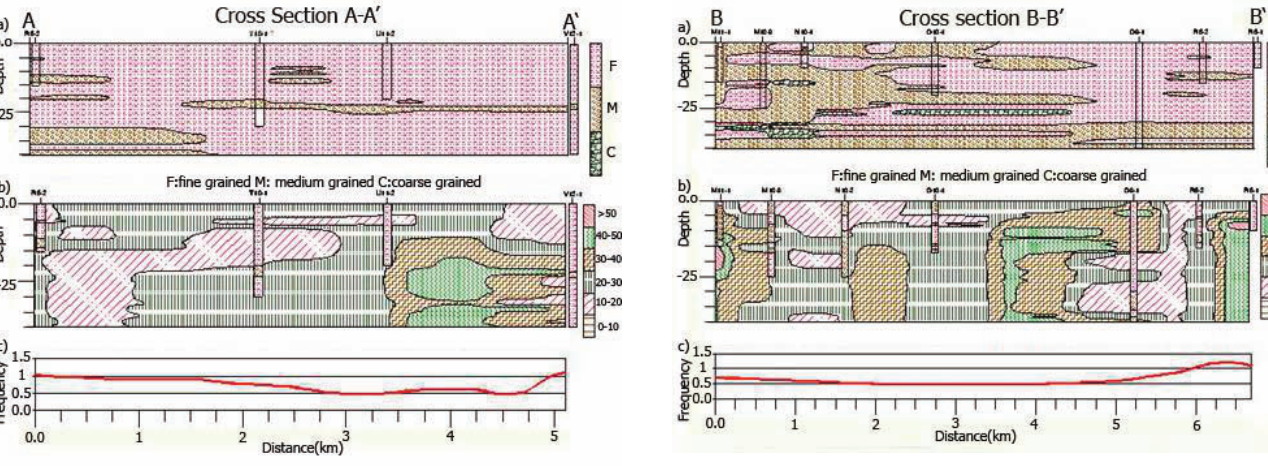
Figure 6. A-A` cross-section. Variations in the soil texture (a), N-SPT (b), and predominant frequency (c).